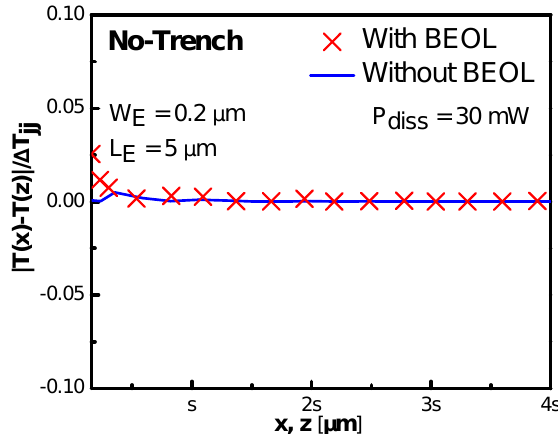
Figure 2. A comparison between the difference in T ( z ) and T ( x ) from TCAD, normalized with the rise in peak junction temperature ∆ T jj , for the structures with and without back-end-of-line (BEOL) heat